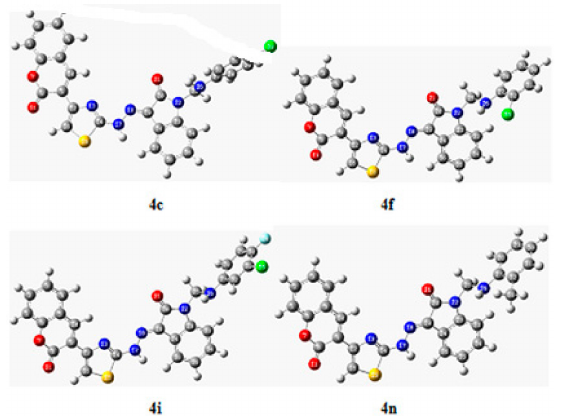
Figure 2. Optimized structure with the numbering of In-H synthesized derivatives.